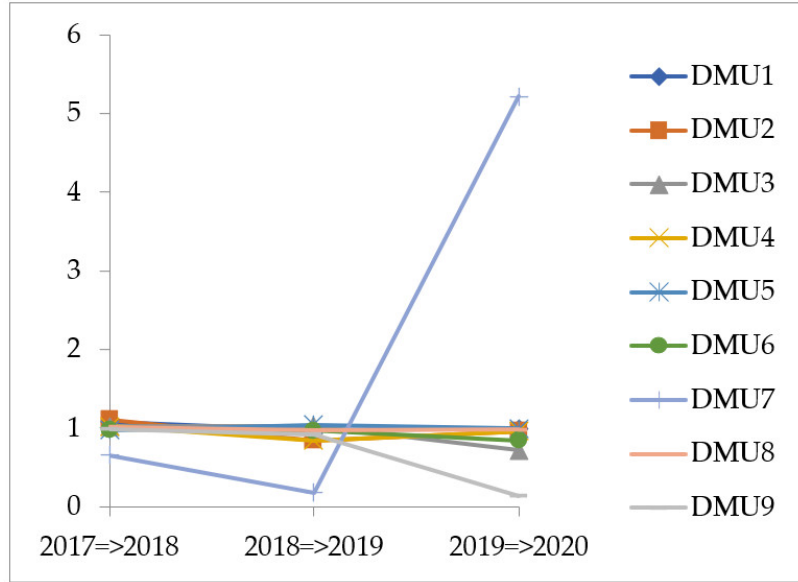
Figure 5. Total factor productivity of DMUs from 2017 to 2020 .